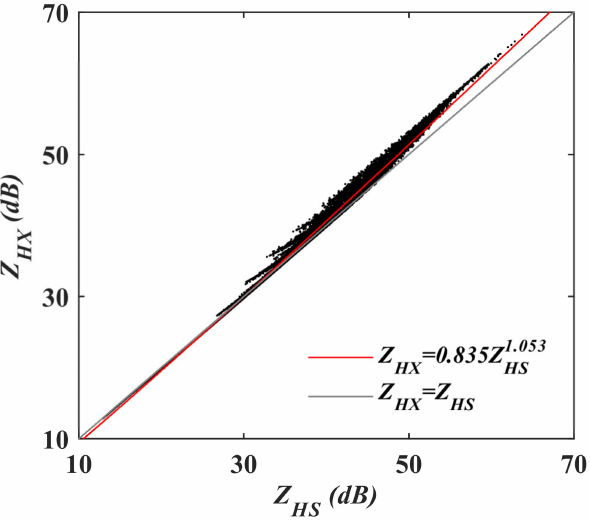
Figure 6. Simulated reflectivity distribution at X-band ( Z HX ) and S-band ( Z HS ) using DSD measurement